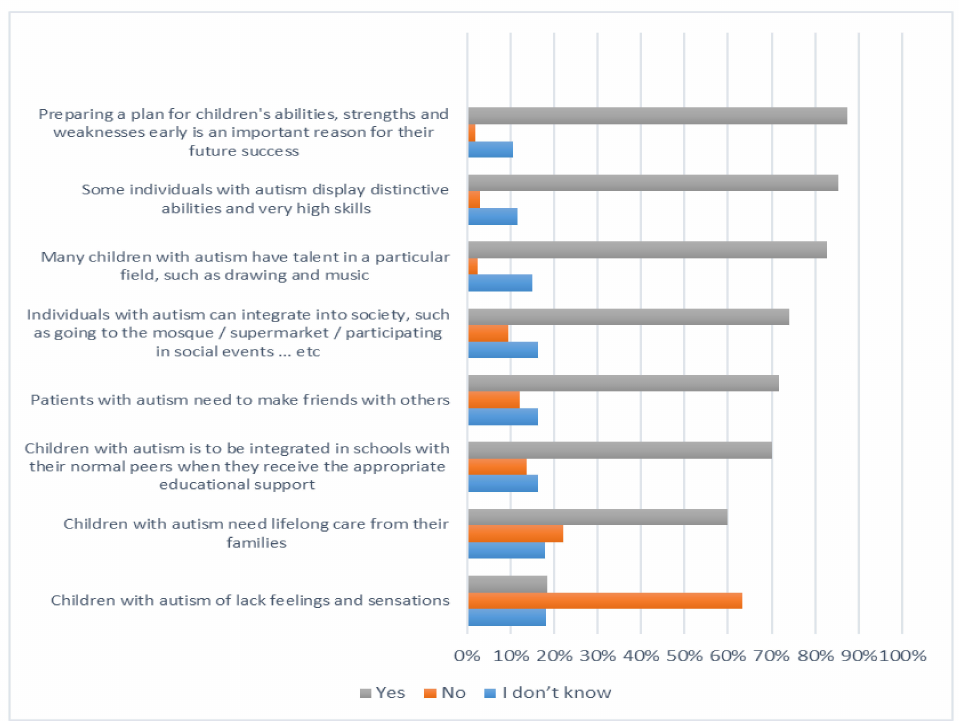
Figure 3. The level of knowledge of the abilities and needs of children with autism